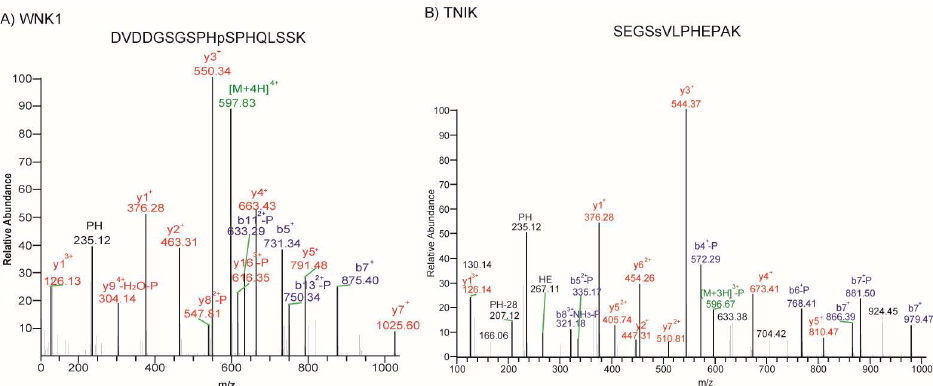
Figure 4. MS/MS spectra of phosphopeptides. Spectral images of hyperphosphorylated kinases. ( A ) WNK1; ( B ) TNIK (TRAF2 and NCK-interacting protein